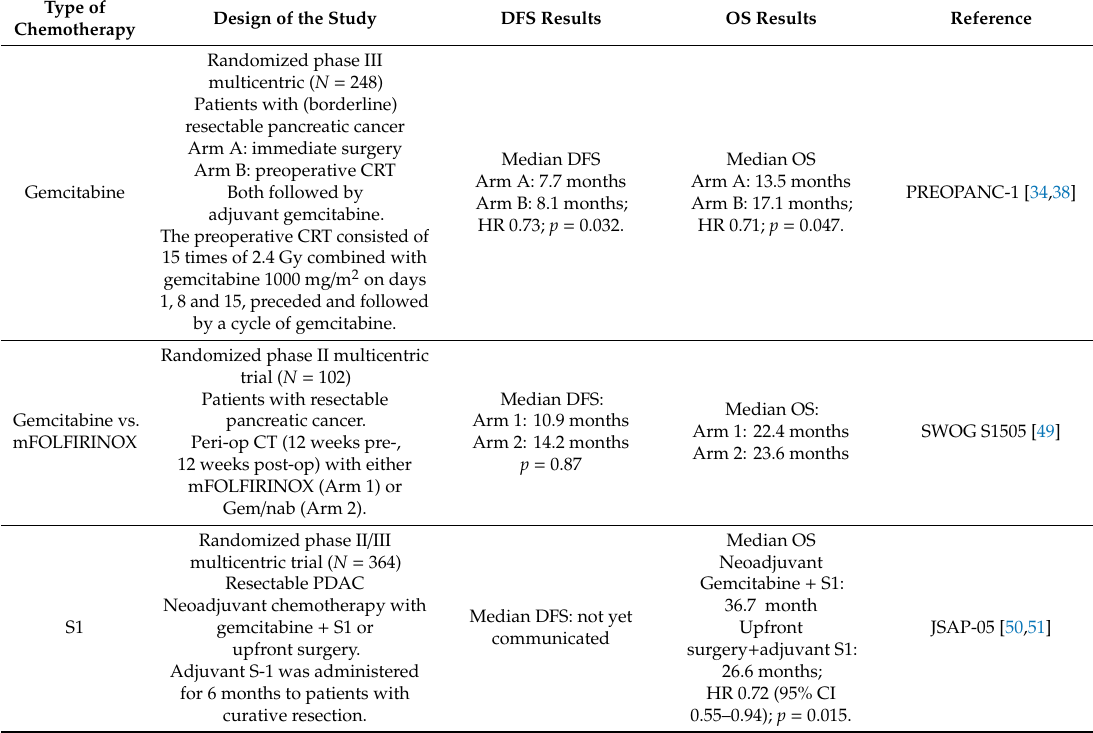
Table 3. Main Phase II / III studies evaluating peri-operative chemotherapy